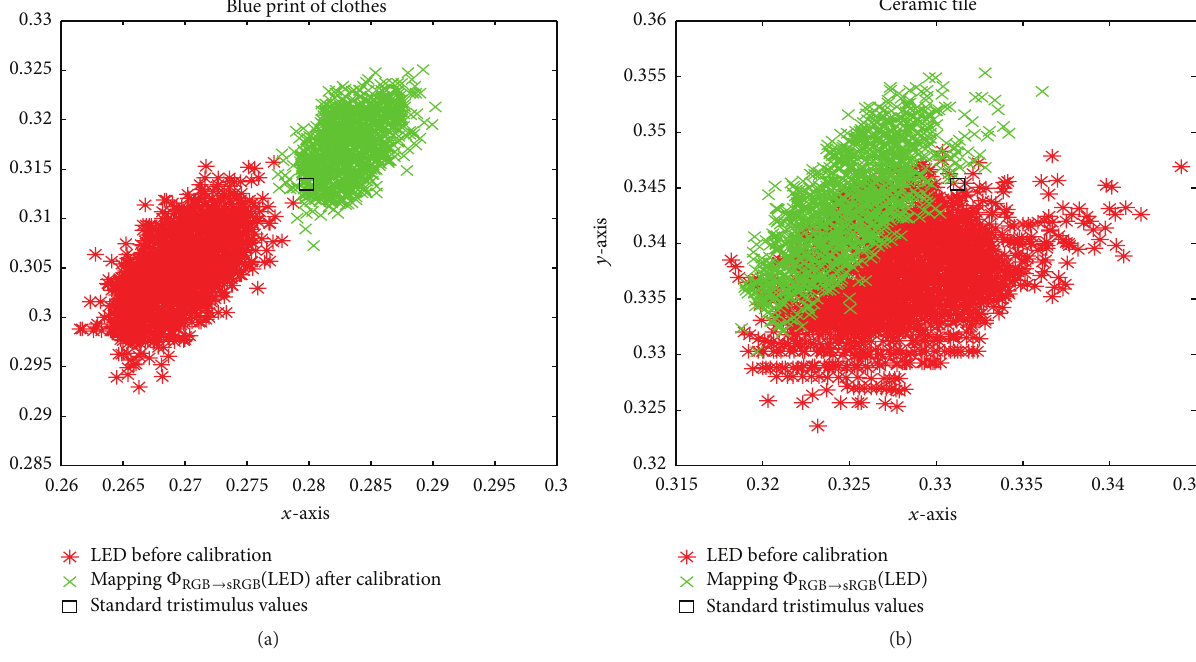
Figure 12: The 𝑥 - 𝑦 chromaticity diagram. (a) Blue printed matter and (b) middle region of ceramic